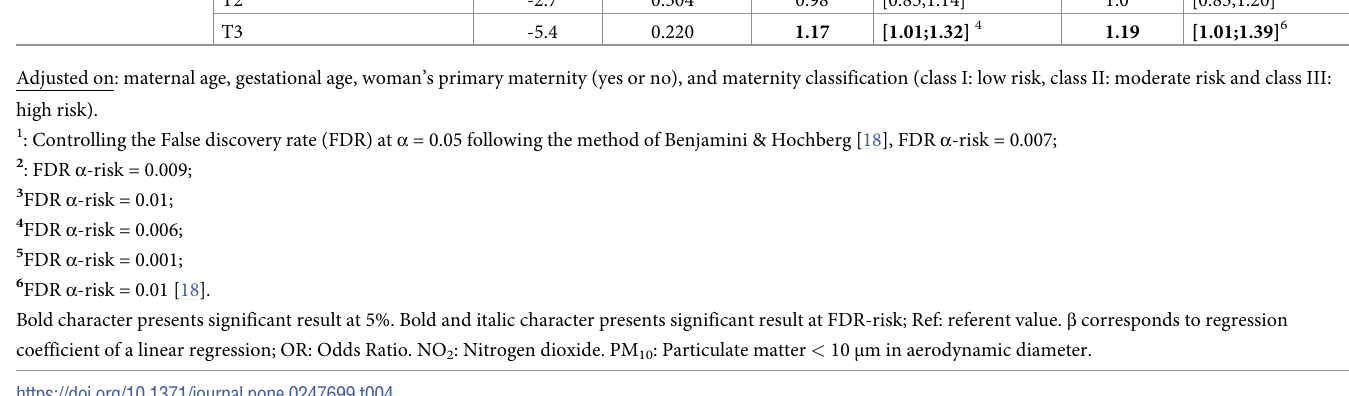
Table 4. Measures of associations and p-value (or 95% confidence interval) for 10 μ g/m 3 increase in concentrations of air pollutants by trimesters of pregnancy from regression models (defined as model 1 in §Material and methods) adjusted for individual covariates for boys. BOYS Birth weight Low birth weight Term low birth weight Air pollutants Window of